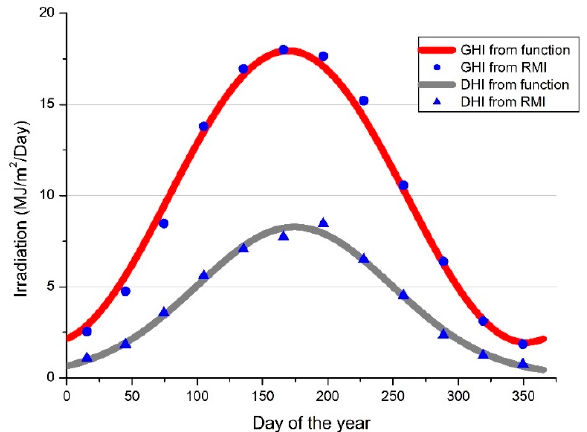
Figure 4. A comparison between the twelve values from the Royal Meteorological Institute (RMI) database and fitted function of daily GHI and DHI calculated for Flanders.